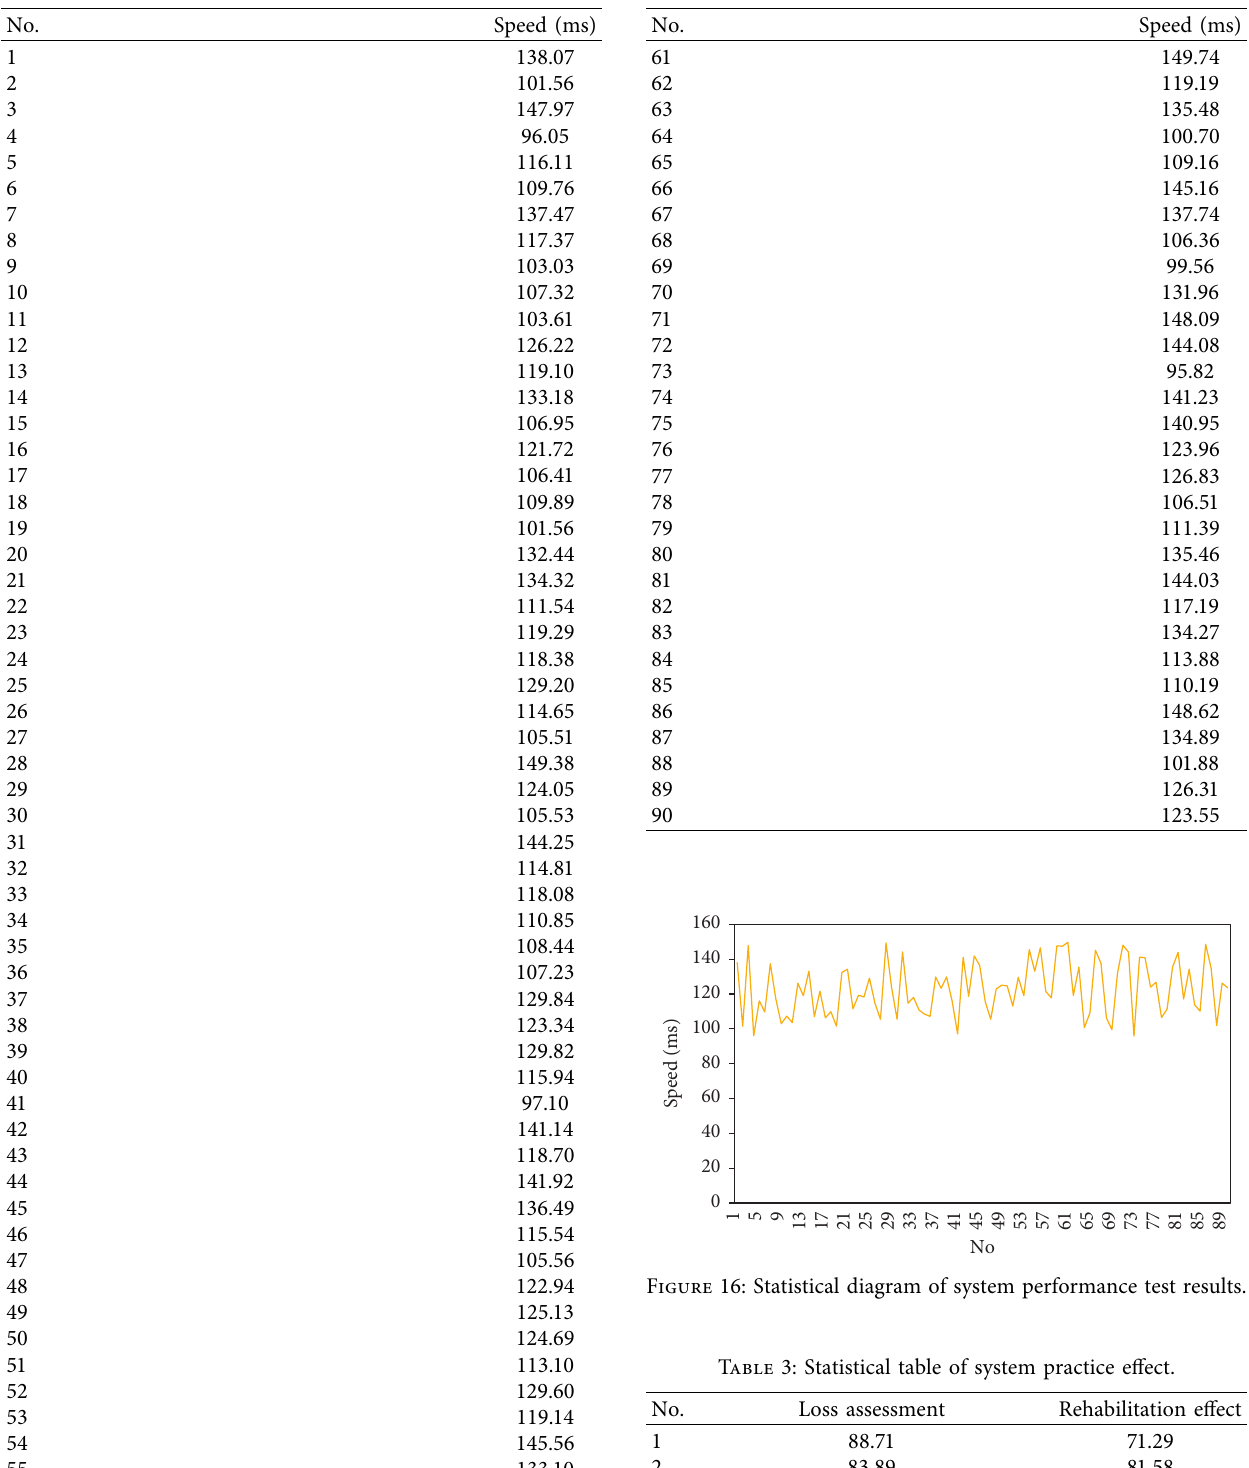
Table 2: Statistical table of system performance test results.